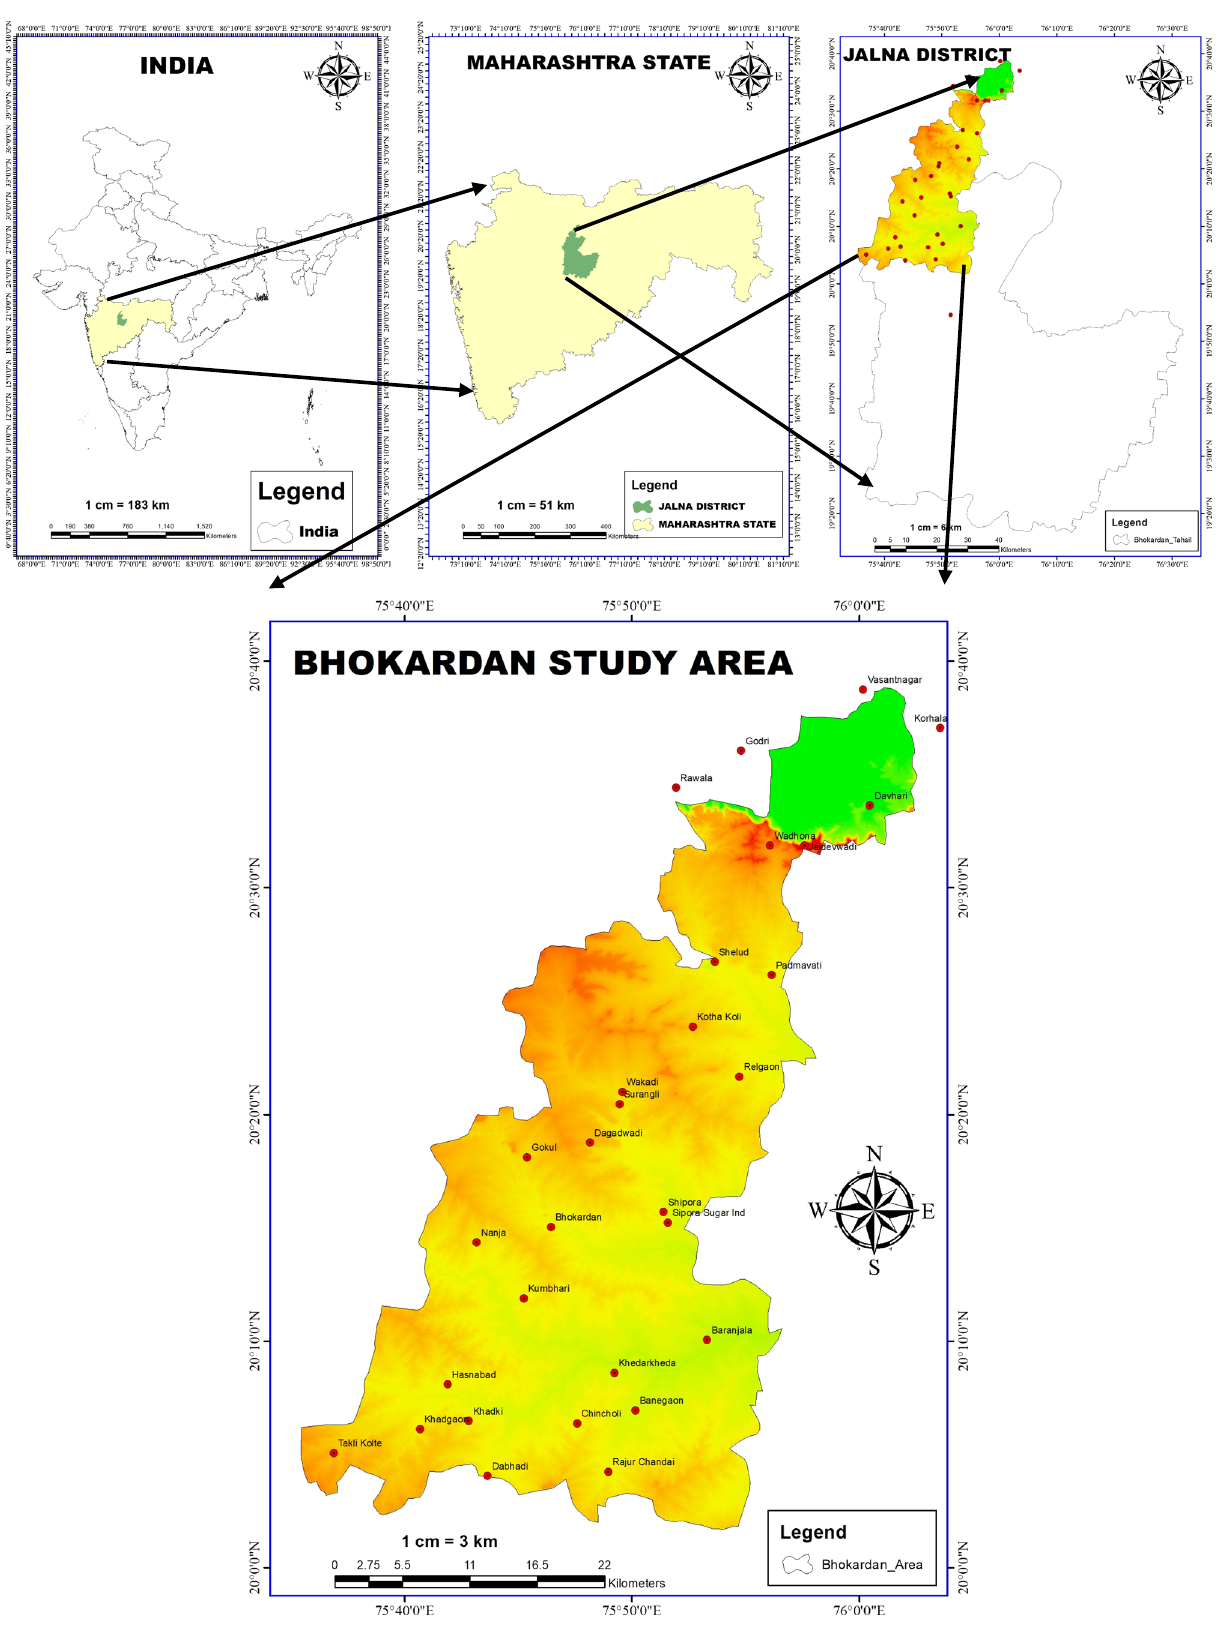
Fig. 1 The location map of the study